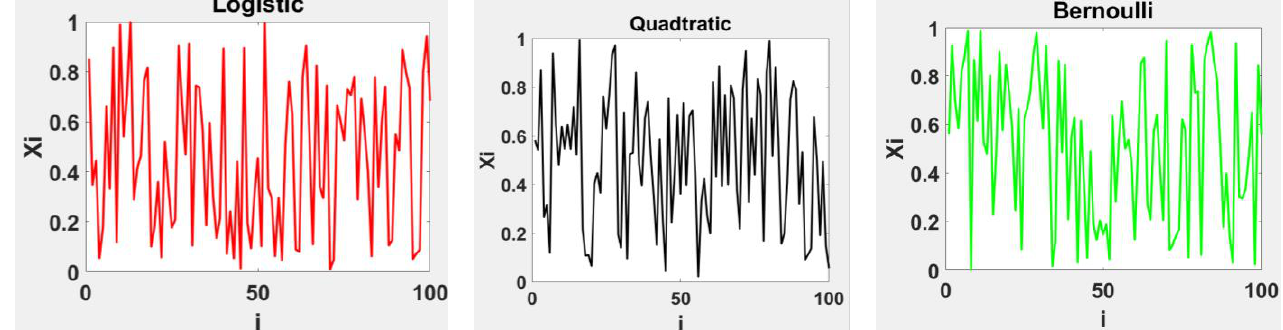
Figure 4. Chaotic maps used for modelling the chaotic behavior of the chimps. The schematic flowchart of the chimp optimization algorithm is shown in Figure 5. The process starts by randomly taking the initial population of chimps with the individual chimp groups. The objective function evaluates the chimps’ positions. Then, the corresponding steps are repeated until the stopping criteria is satisfied.